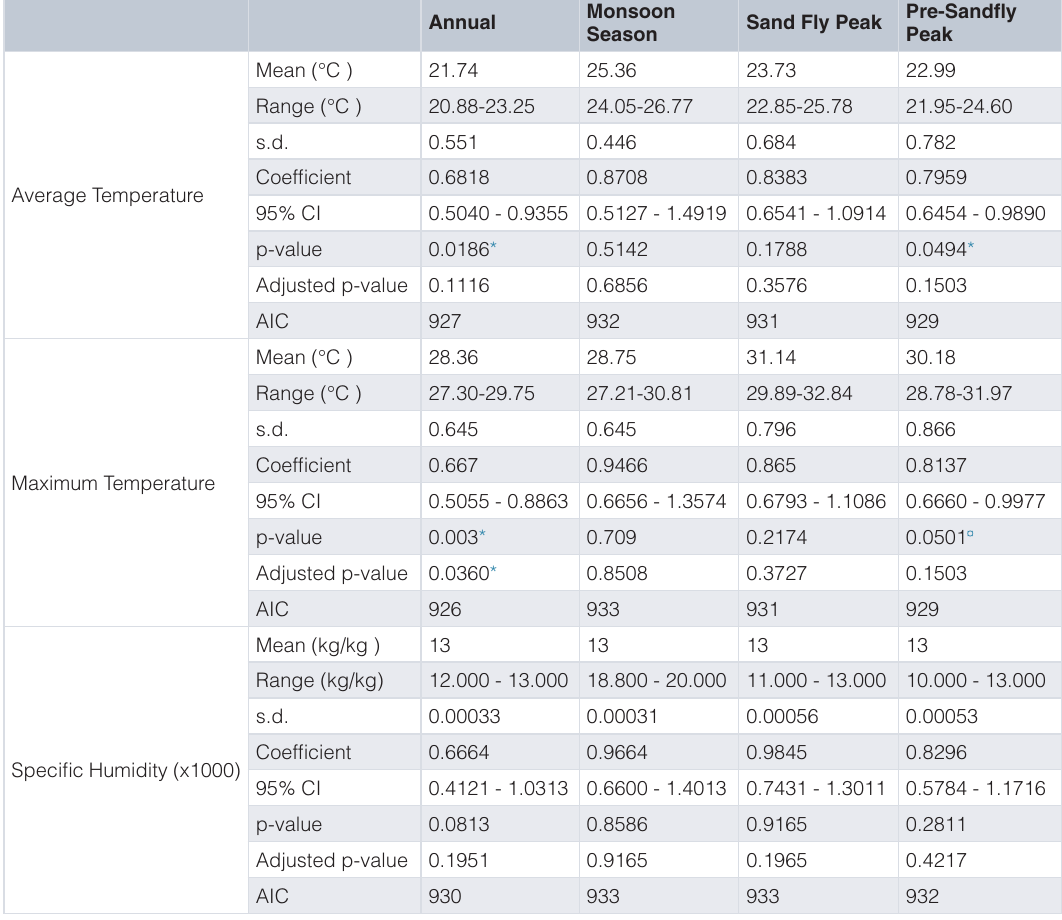
Table 2. Temperature and Humidity descriptive for all time periods. Negative Binomial model with VL incidence using data from GoB only.